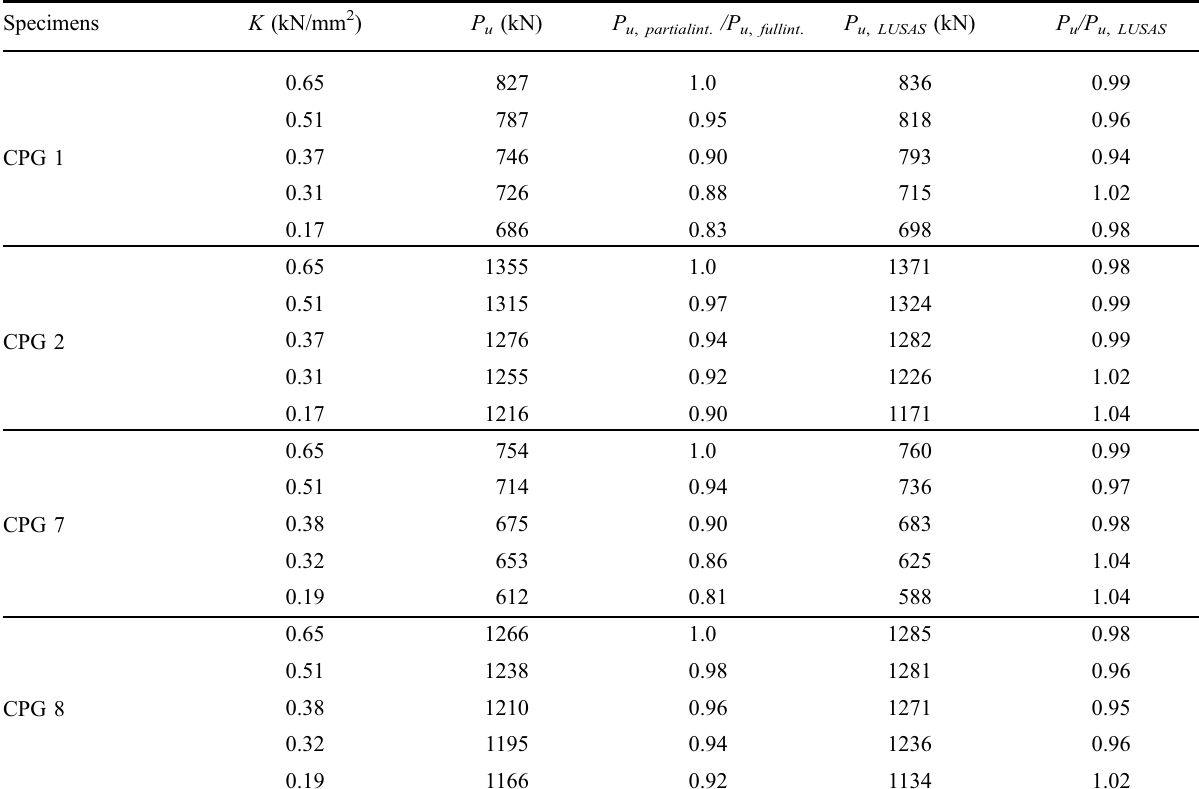
Table 2. Comparison of ultimate loads for girders under single concentrated load at mid-span Specimens K (kN/mm 2